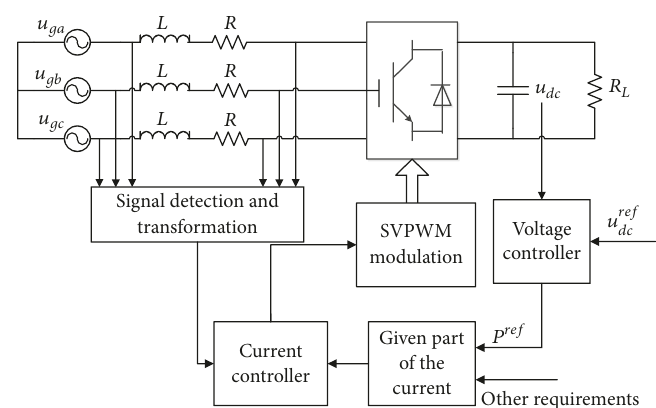
Figure 2: Control structure of grid-connected